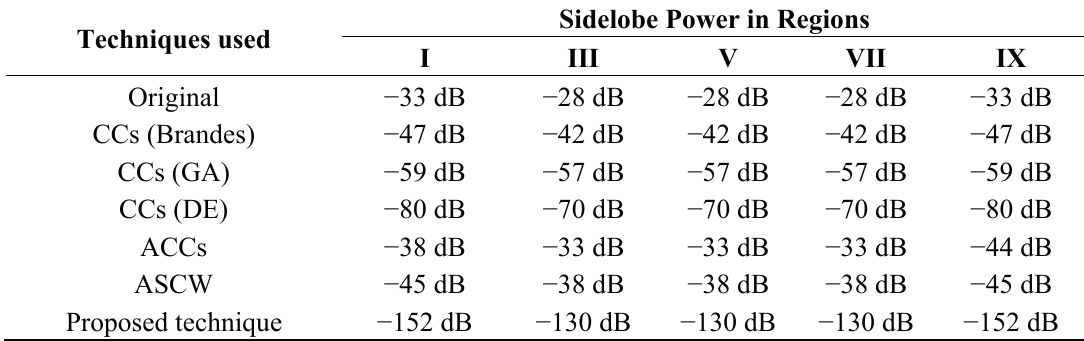
Table 2. Comparison of sidelobe suppression between existing and proposed